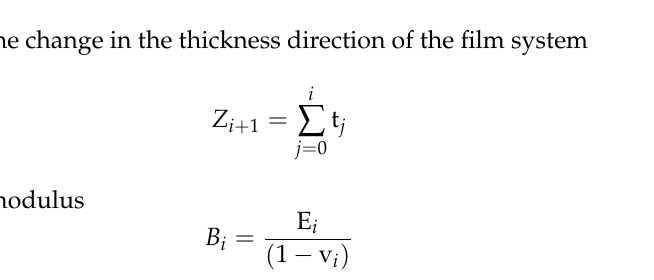
Z represents the change in the thickness direction of the film